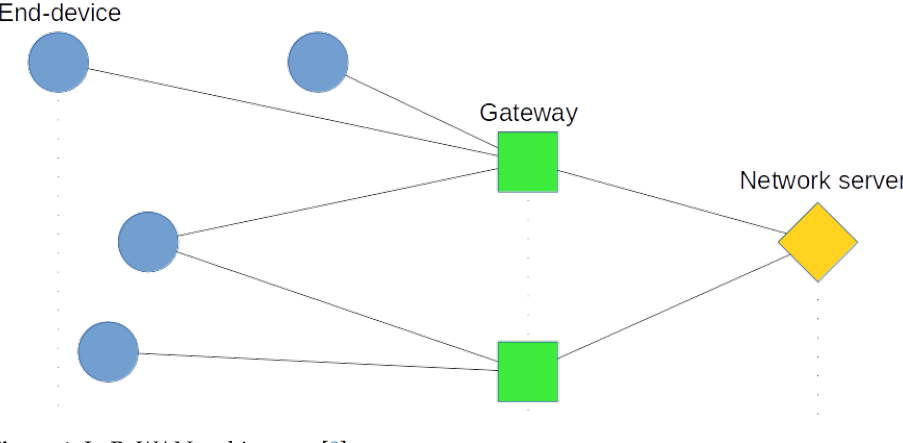
Figure 1. LoRaWAN architecture